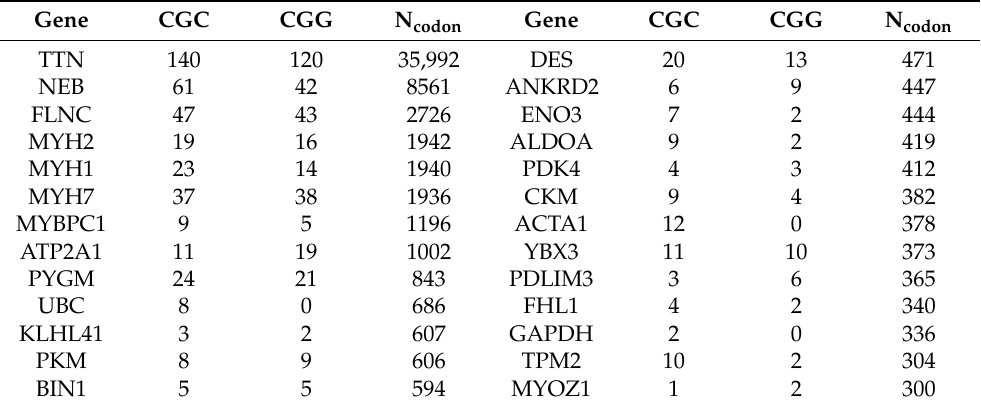
Table 2. Usage of CGC and CGG codons in the most highly expressed genes in skeletal muscles. Only those CDSs with the number of codons (N codon ) greater than 300 were included.